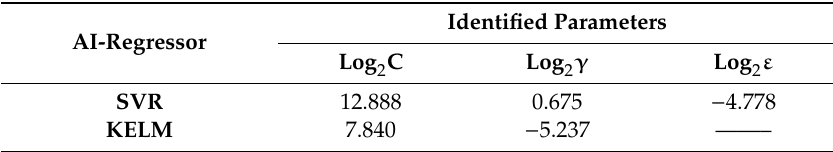
Table 1. Optimal identified parameters for each AI.